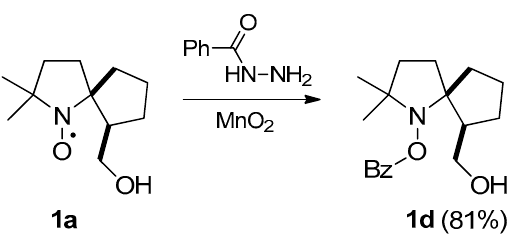
Scheme 7. Synthesis of N -benzoyloxy derivative 1d .